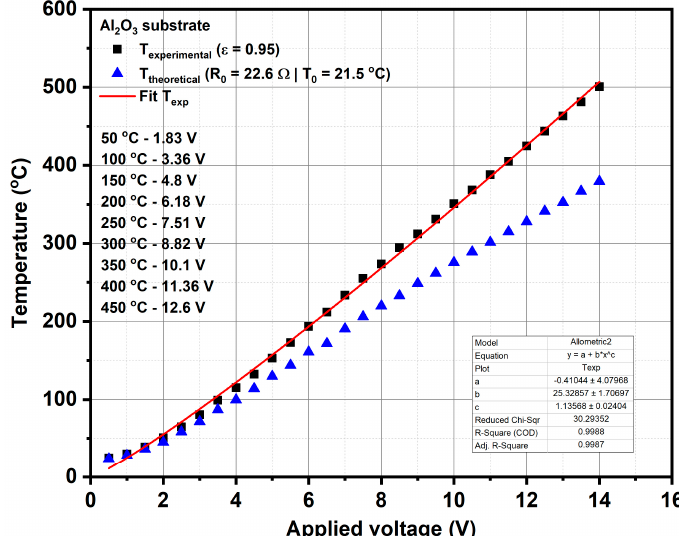
Figure 1. Temperature calibration curve with respect to the applied voltage; R 0 is the electrical resistance at room temperature of 21.5 °C.